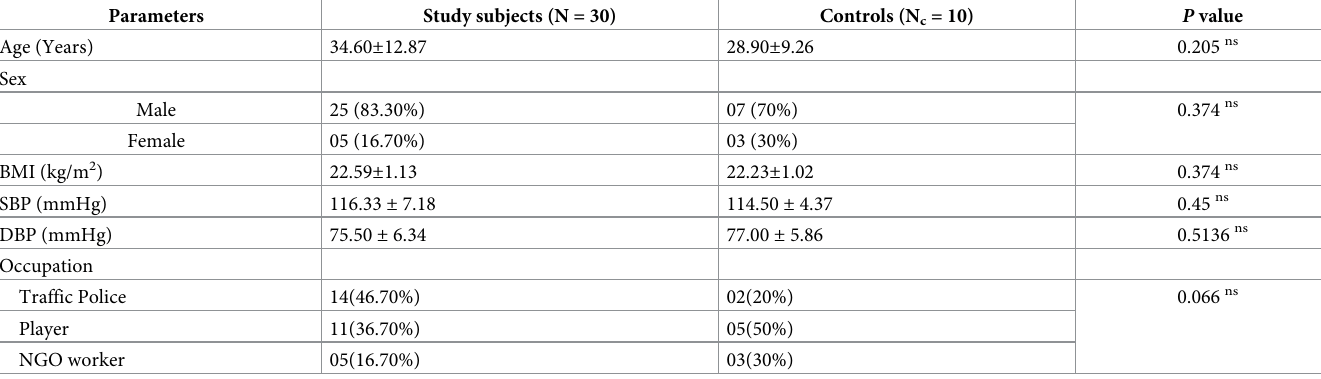
Table 1. Socio-demographic characteristics of the study subjects (N t =